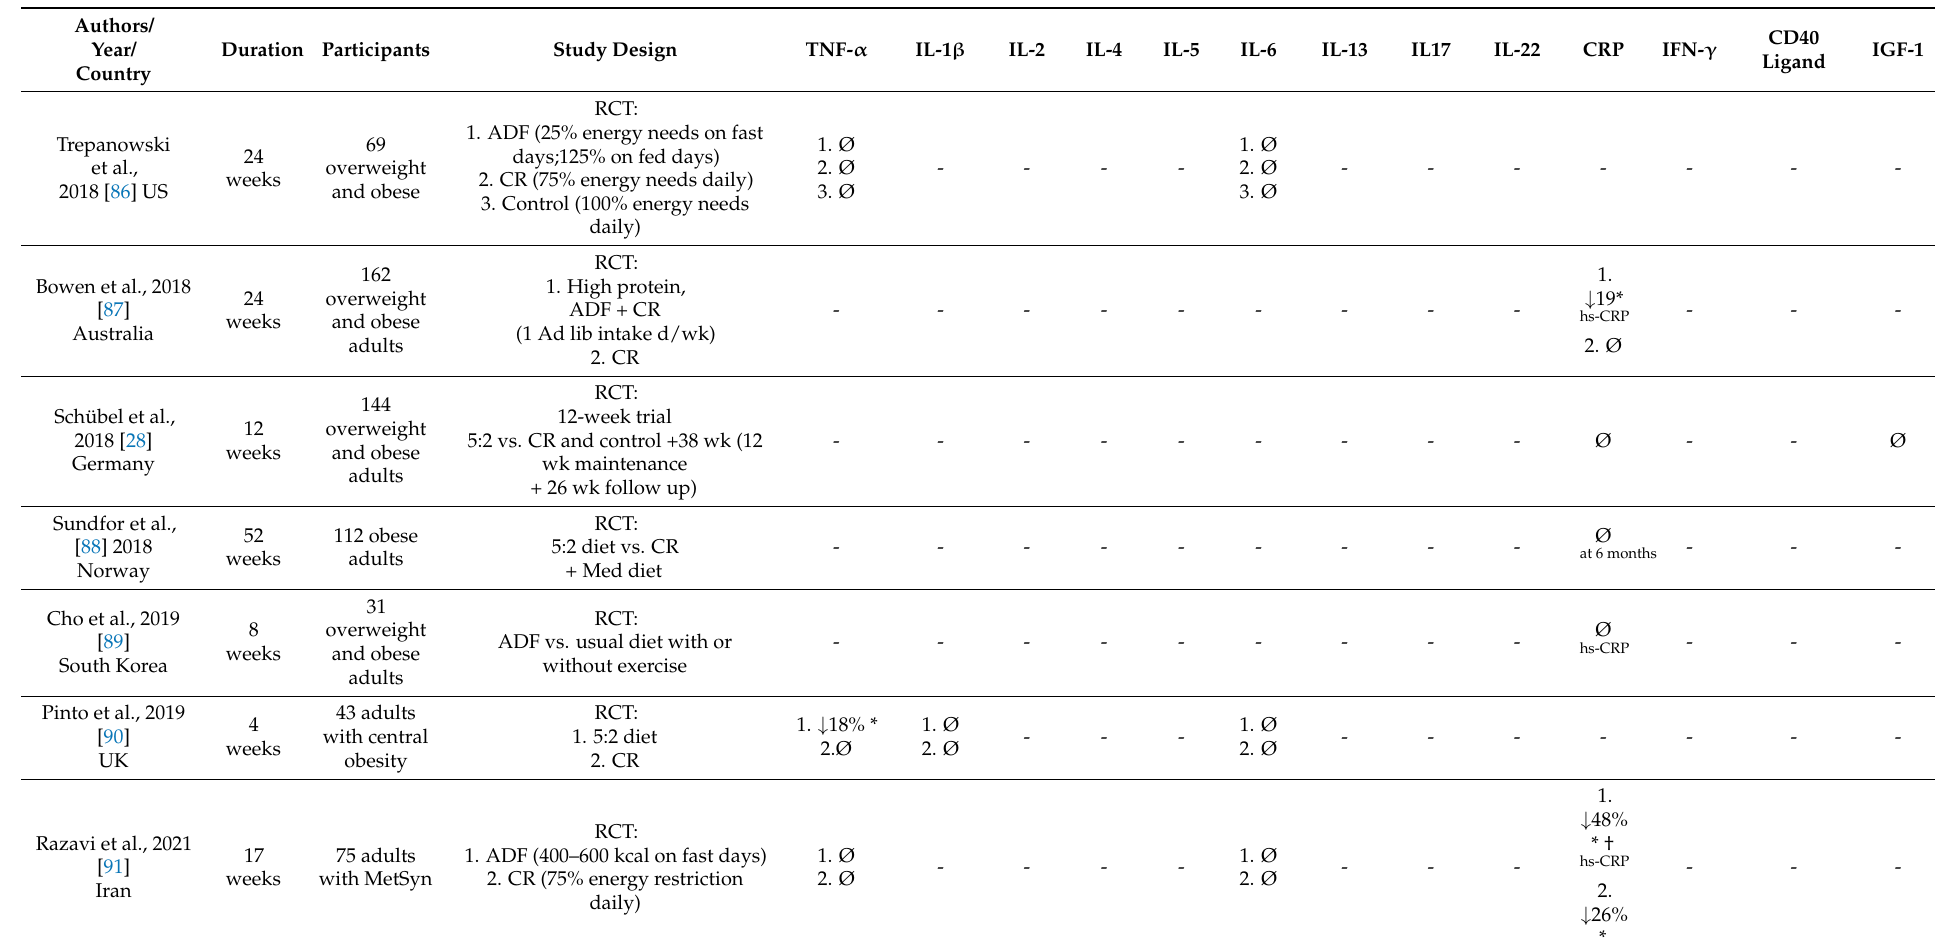
Table 4. Summary of Randomized controlled trials (RCTs) on the impact of intermittent calorie restriction on inflammatory